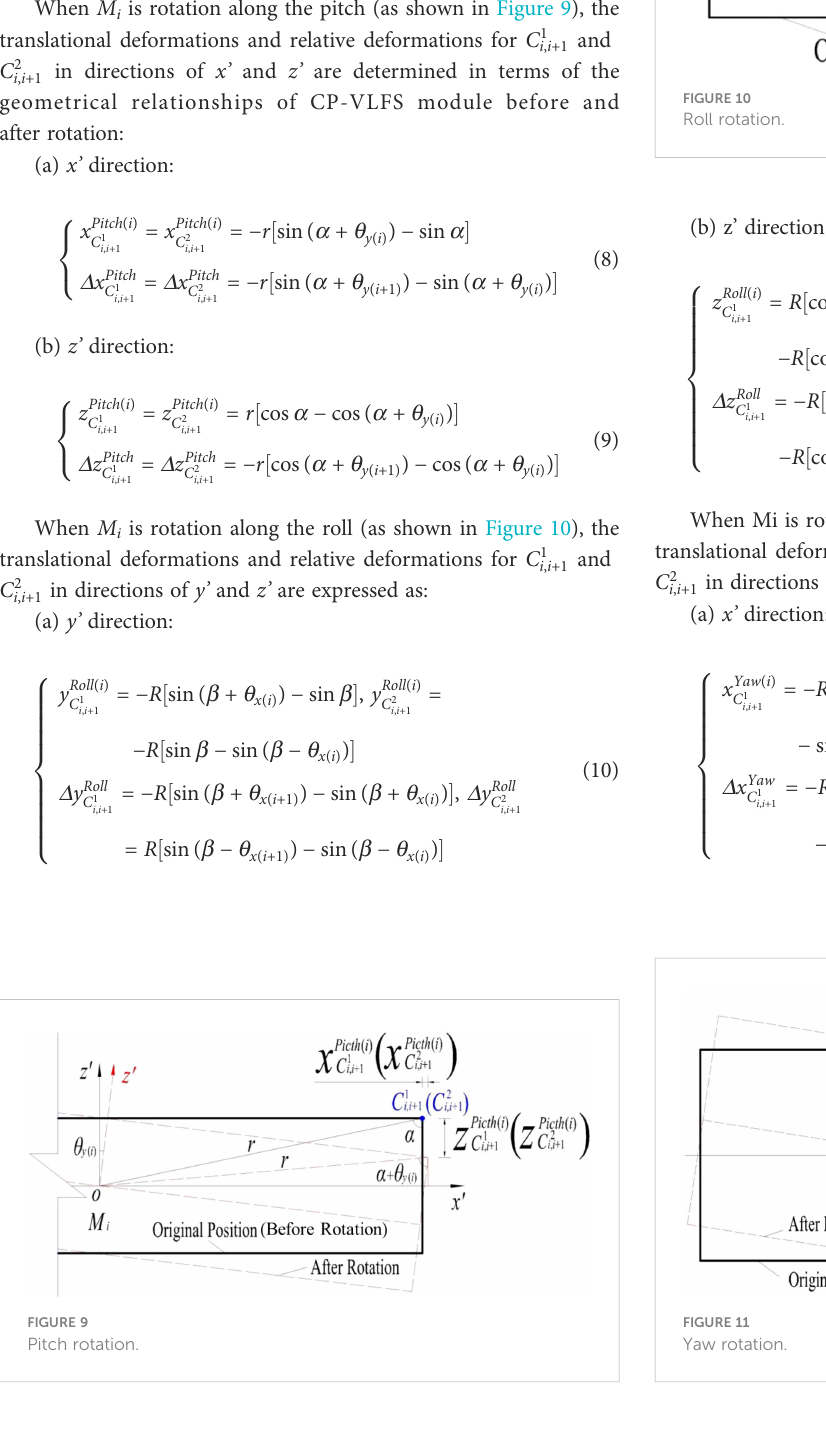
FIGURE 10 Roll rotation.